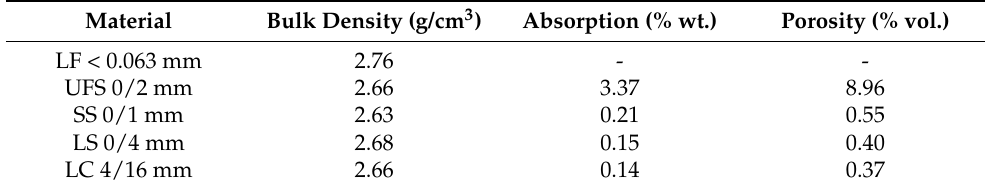
Table 1. Physical properties of the aggregates used. Material Bulk Density (g/cm 3 ) Absorption (% wt.) Porosity (%